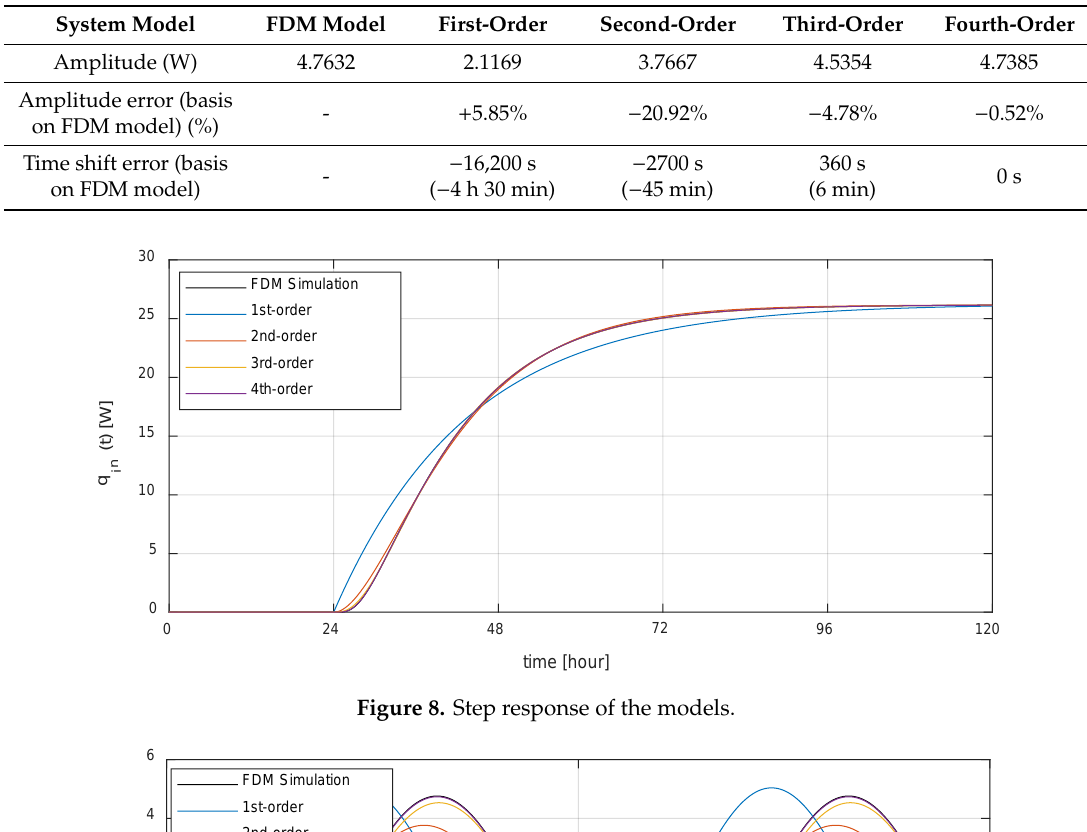
Table 7. Amplitude and time shift comparison with the FDM sinusoidal response.